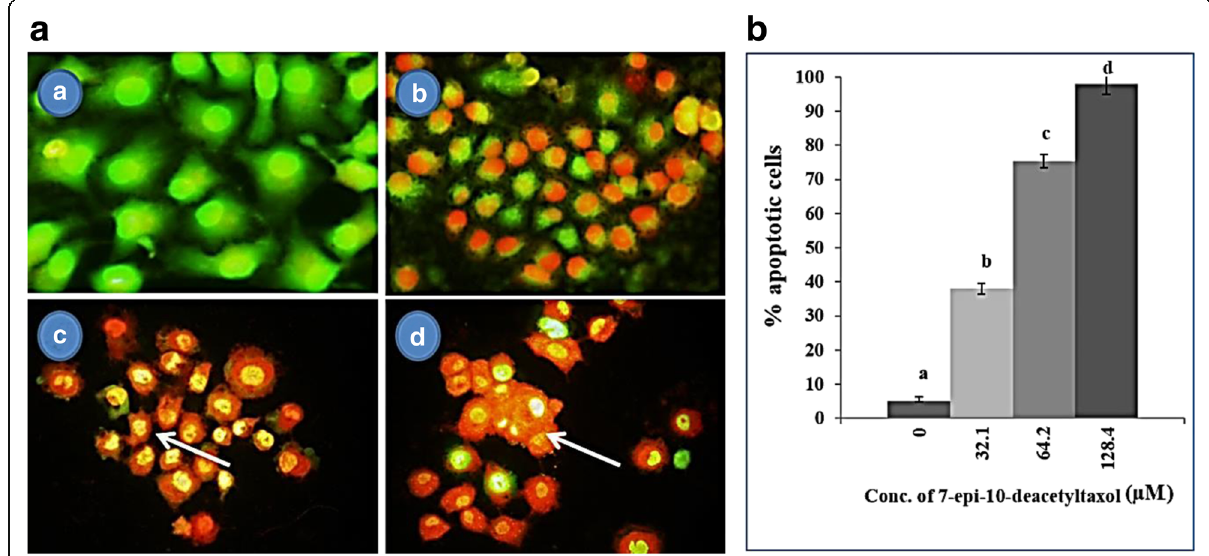
Fig. 7 Fungal EDT induced apoptosis in HepG2 cells. a A Untreated control cells, (a B-D ) HepG2 cells treated with 32.1 μ M, 64.2 μ M and 128.4 μ M, respectively of fungal EDT. Fluorescence microphotographs of untreated and treated cells were obtained after AO/EB staining. Arrows pointing towards cells undergoing apoptosis, ( b ) The number of cells displaying apoptosis. Data are represented as means ± SD from 3